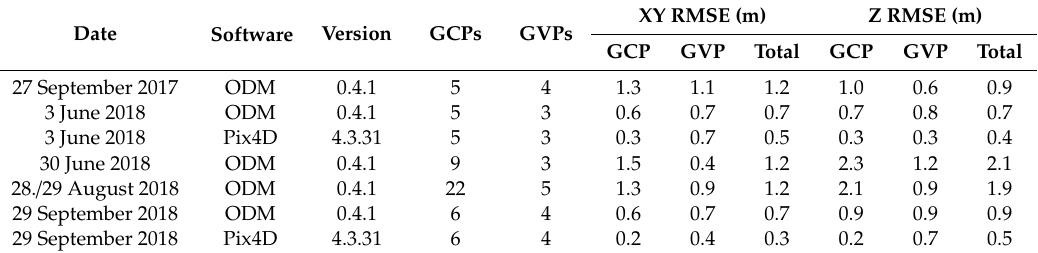
Table 3. Root mean square error (RMSE) of the orthophotos (XY) and DSMs (Z) generated with OpenDroneMap and Pix4D based on the evaluation of all available GCPs and